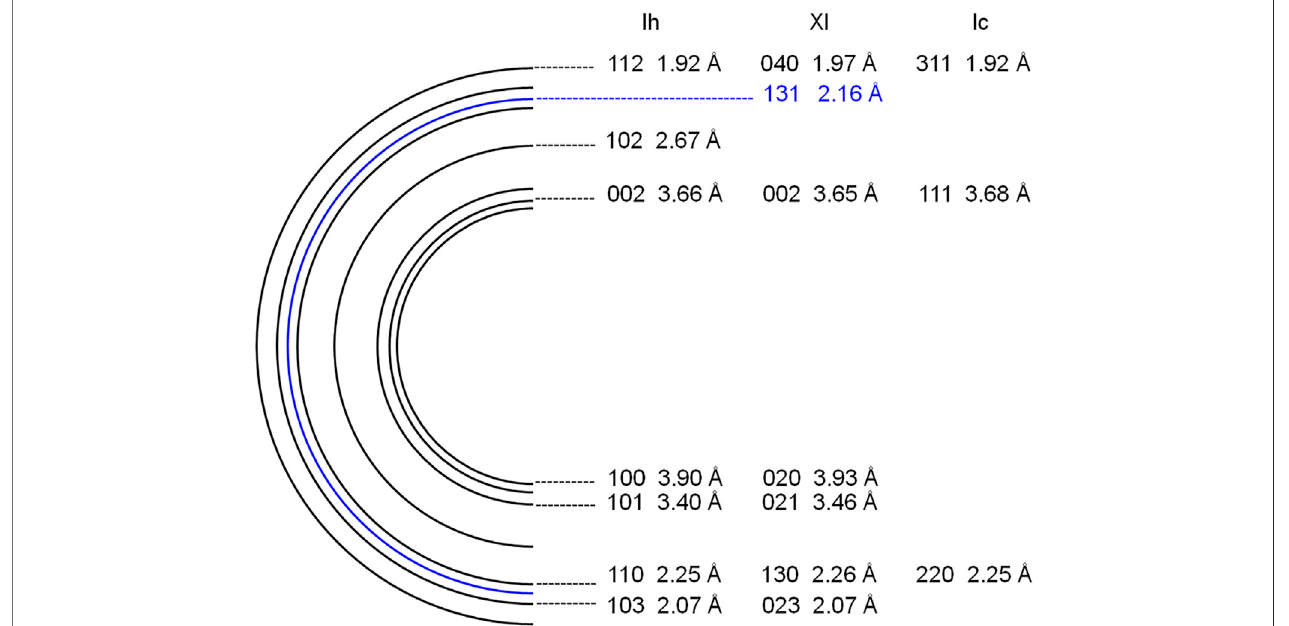
FIGURE 5 | Schematic illustration of electron powder diffraction patterns of ice Ih, ice XI, and ice Ic.